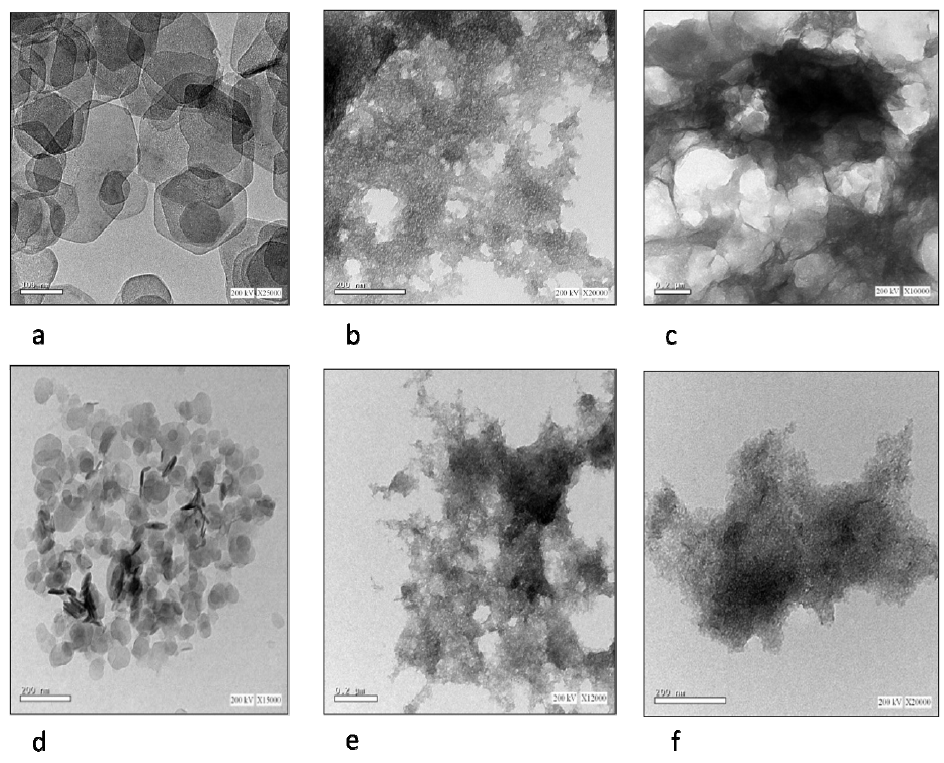
Figure 4. ( a ) represents TEM of synthesized MgAl-LDH (MgLDH), ( b ) represents TEM of synthe- sized NiAl-LDH (NiLDH), ( c ) represents TEM of synthesized MgAl-LDH intercalated green tea oil (MgLDH-GT), ( d ) represents TEM of synthesized MgAl-LDH intercalated fennel oil (MgLDH-F), ( e ) represents TEM of synthesized NiAl-LDH intercalated green tea oil (NiLDH-GT), ( f ) represents TEM of synthesized NiAl-LDH intercalated fennel oil (NiLDH-F).